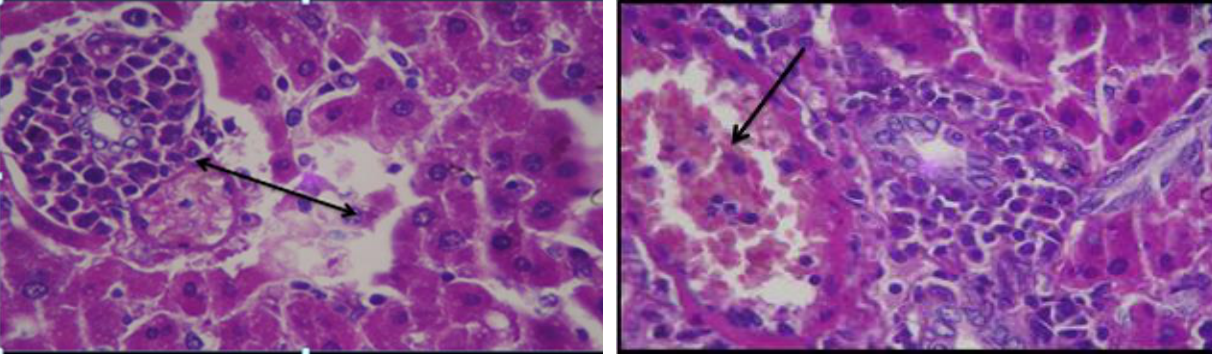
Figure,4: Photomicrographs showing histology of liver tissue from group T1 showed